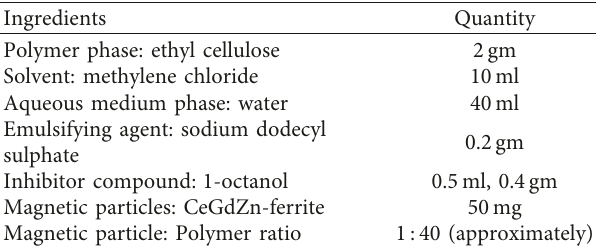
Table 1: Ingredients for ethyl cellulose-encapsulated CeGdZnFe using polymer emulsion.